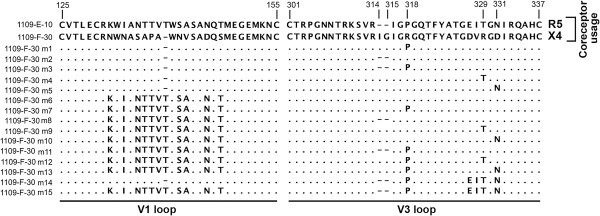
C-HIV Env mutants. Amino acid sequences of the Env mutants, aligned against the gp120 sequence of the X4 1109-F-30 sequence. The sequences and descriptions of these Env mutants have been reported previously [8], and are included again here to assist in the interpretation of the functional data. Dots indicate residues identical to 1109-F-30, dashes indicate gaps. Numbers refer to amino acid positions in the V1 and V3 loop regions. Descriptions of the Env mutants are provided in greater detail in the Methods.